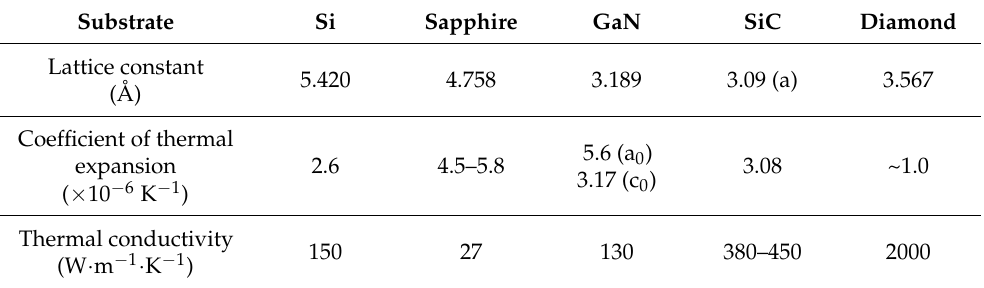
Table 1. Properties of relevant materials